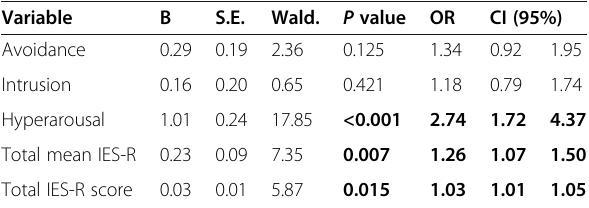
Table 3 Adjusted logistic regression of COVID-19 survivors and control subjects by PTSD symptoms